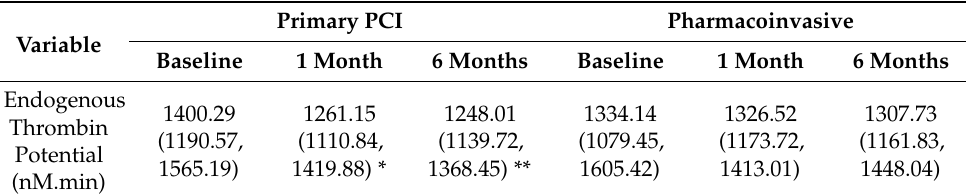
Figure 1. Endogenous thrombin potential (ETP) levels at baseline, 1-month and 6-months in patients receiving primary percutaneous coronary intervention (PCI) and pharmacoinvasive therapy. Table 2. Baseline and follow-up thrombin generation parameters.